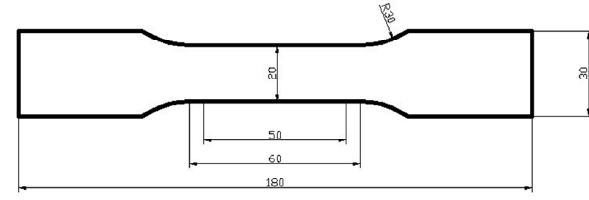
Figure 10. The dimensions of tensile specimen.